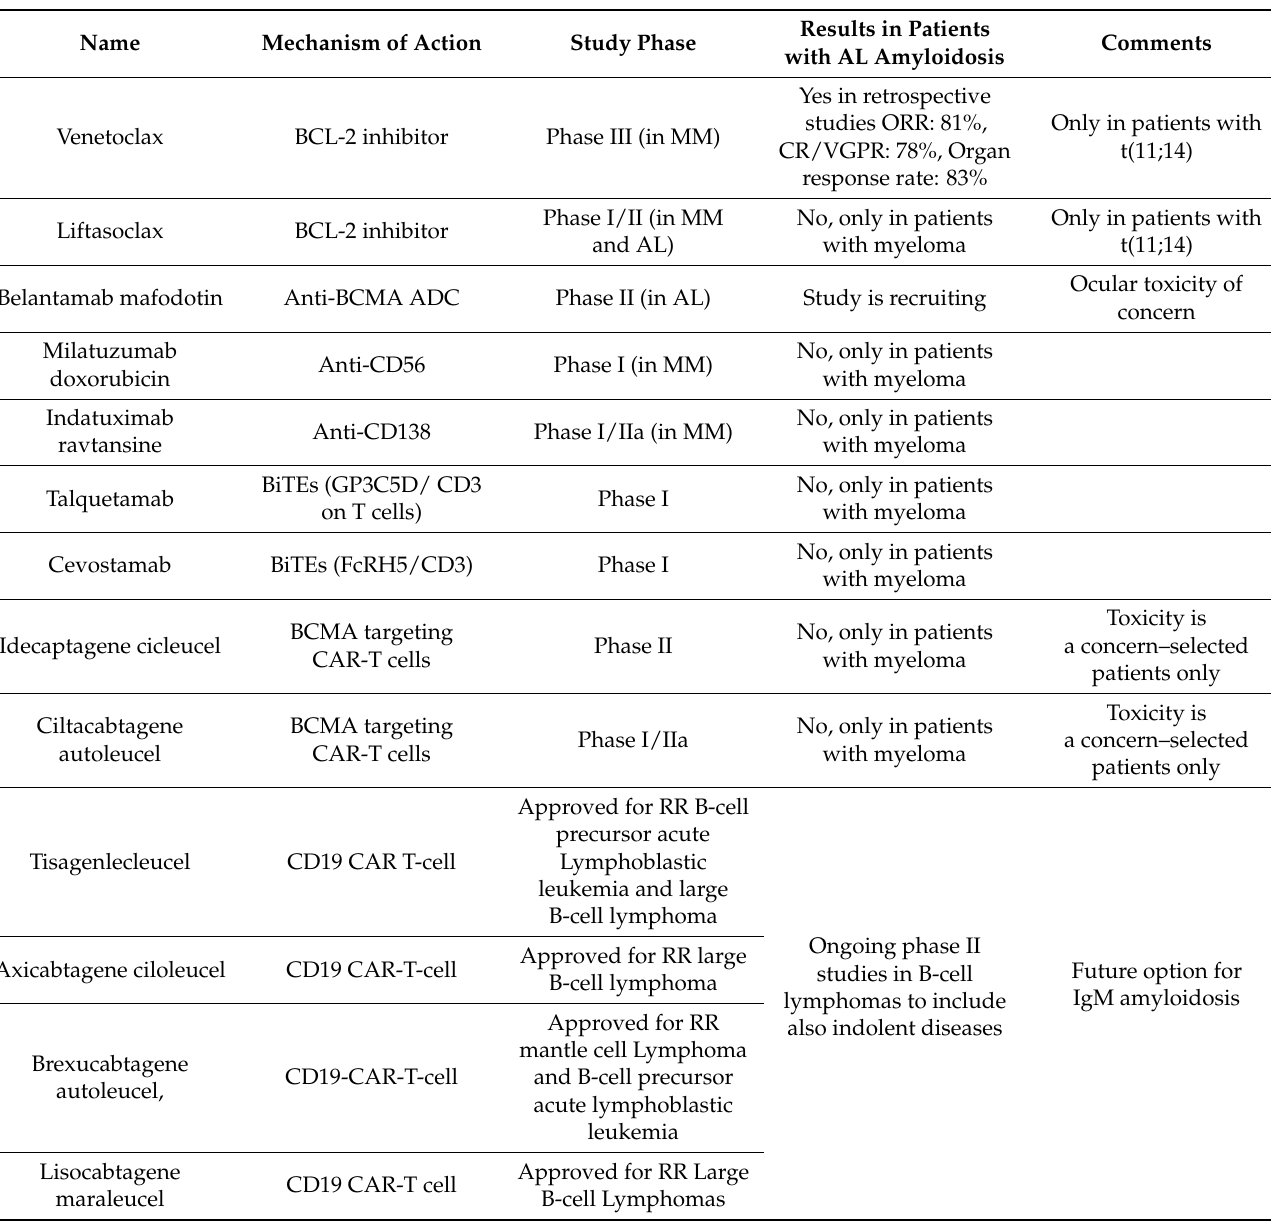
Table 1. Future treatments for AL